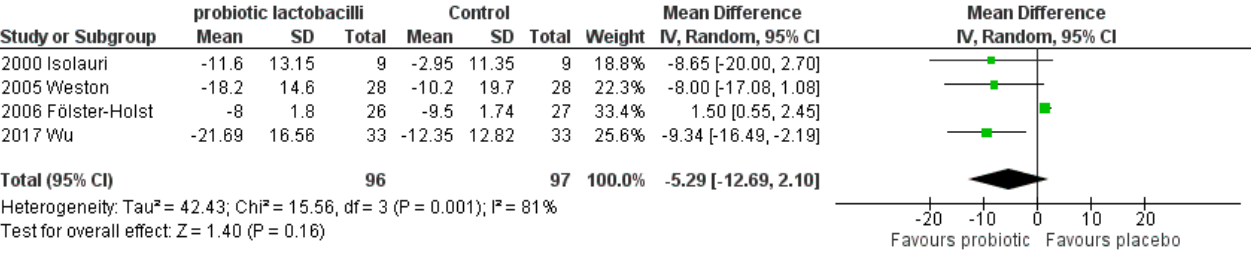
Figure 3. Subgroup meta-analyses of the e ff ect of the included single-strain probiotic Lacticaseibacil- lus rhamnosus , Limosilactobacillus fermentum , Lacticaseibacillus paracasei and Lactiplantibacillus planta- rum strains compared to placebo on the SCORAD index change in children with AD [41–44,46,47,49– 54].